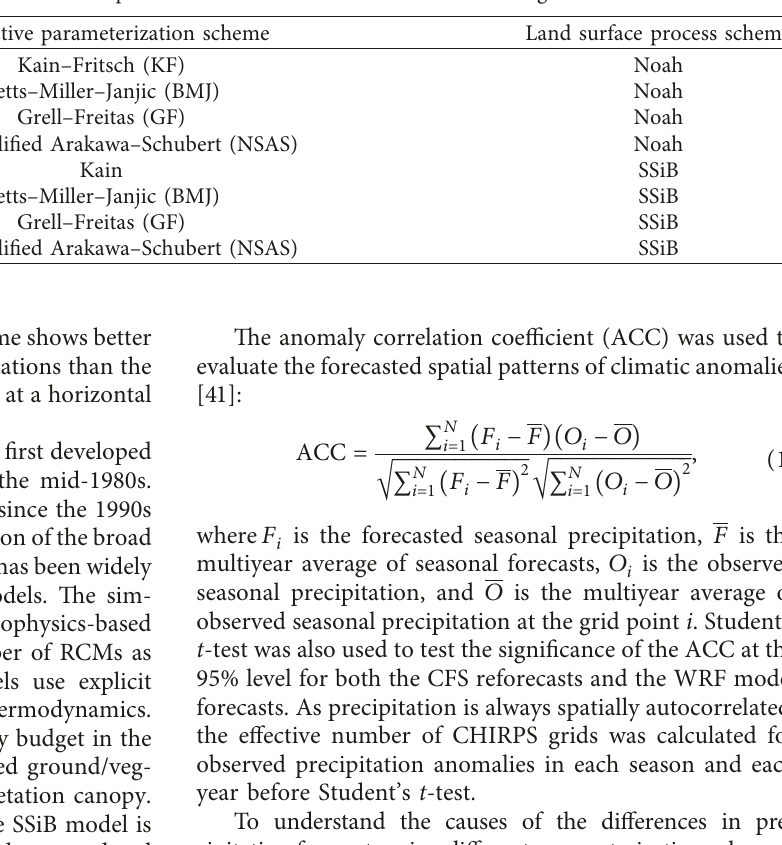
Table 2: Convective and land use parameterization schemes used in